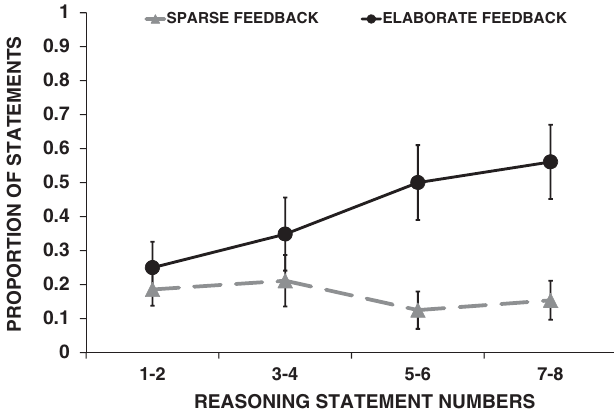
FIG. 2. Proportion of statements coded as principle based over time. Each point represents 13 subjects’ statements averaged for two items consisting of two problems (52 codes). Participants in the elaborate group increased their use of concepts and principles significantly as the session